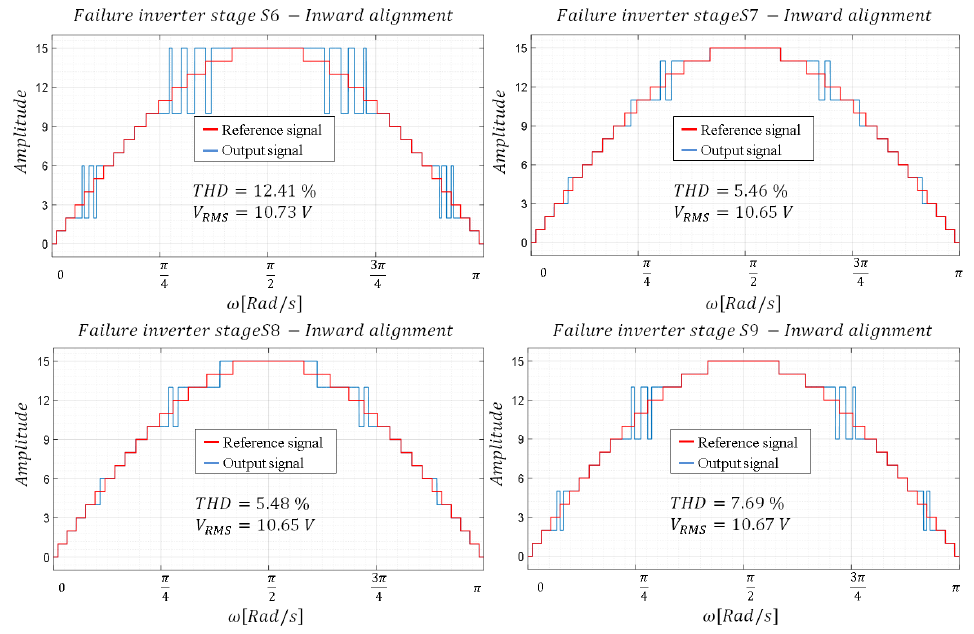
Figure 6. Waveforms—Configuration with a pulse and inward